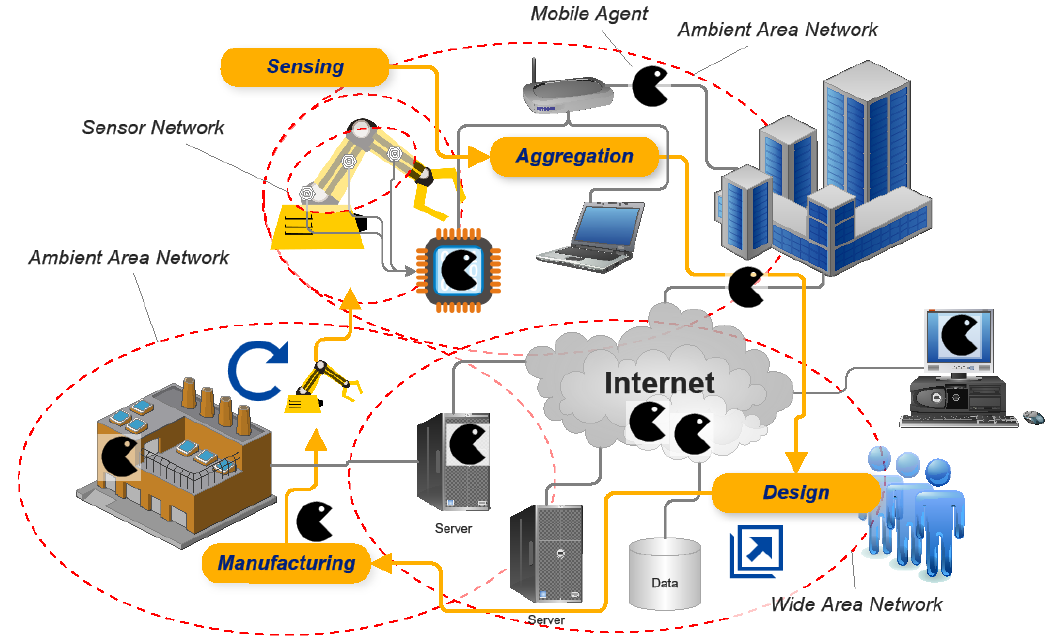
Figure 10. Additive and adaptive Manufacturing with back propagation of sensing data using mobile agents from robots to the design and iteration process resulting in continuous series improvements.